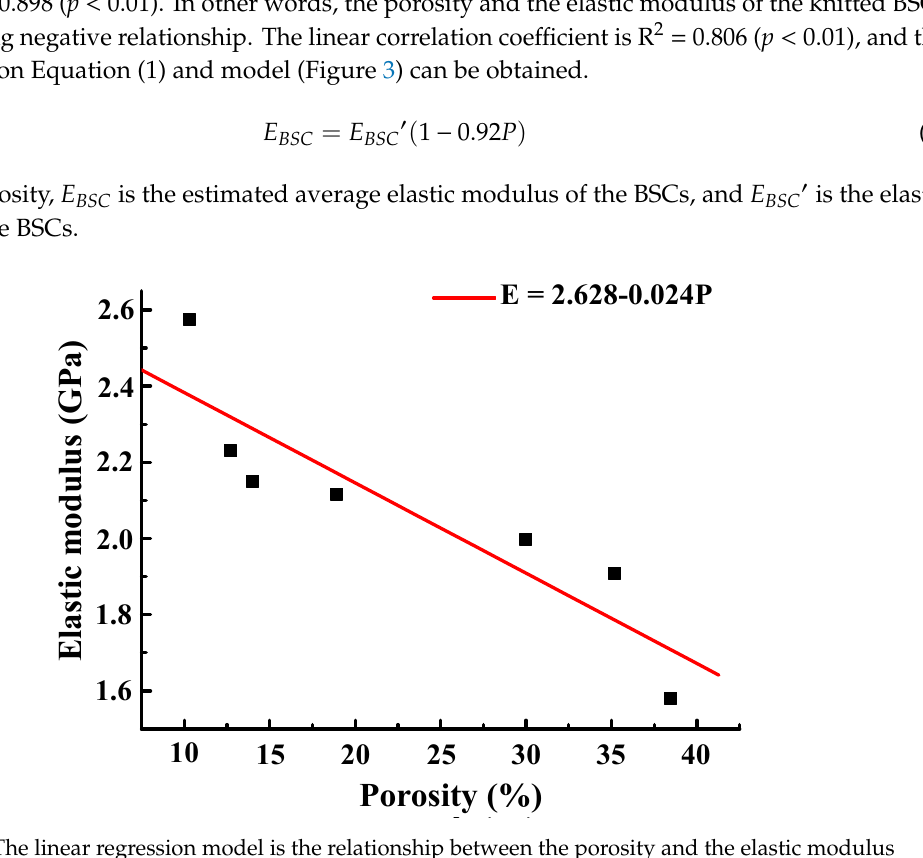
Table 3. Experiment results between the porosity, the elastic modulus of the knitted BSCs, the abdomen circumference decreasing, and the stress of the BSC and human body